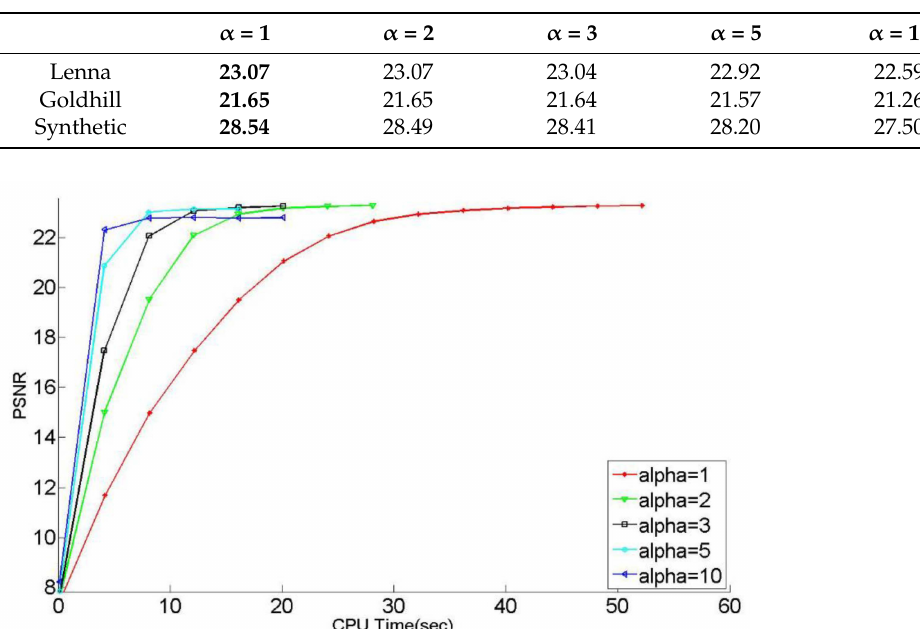
Table 1. PSNR values for different α .